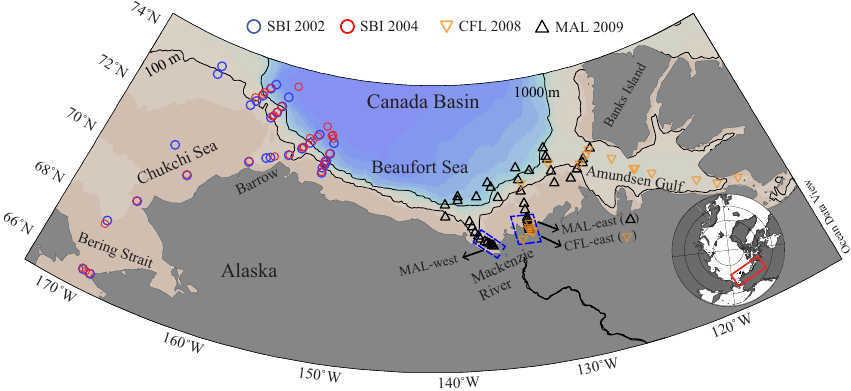
Fig. 1. Locations of sampling stations in the western Arctic Ocean. Four cruises were conducted during the summer and sampled the shelf, slope, and basin environments of the Chukchi and Beaufort Seas. Blue circles – SBI 2002; red circles – SBI 2004; brown inverse triangles – CFL 2008; black triangles – MAL 2009. The Mackenzie River plume was surveyed during CFL 2008 (CFL-east) and MAL 2009 (MAL-west and MAL-east). The 100 and 1000m isobaths are shown. Table 1. Physicochemical characteristics in shelf, slope and basin waters of the Chukchi and Beaufort Seas ∗ . Cruise Depth Temperature